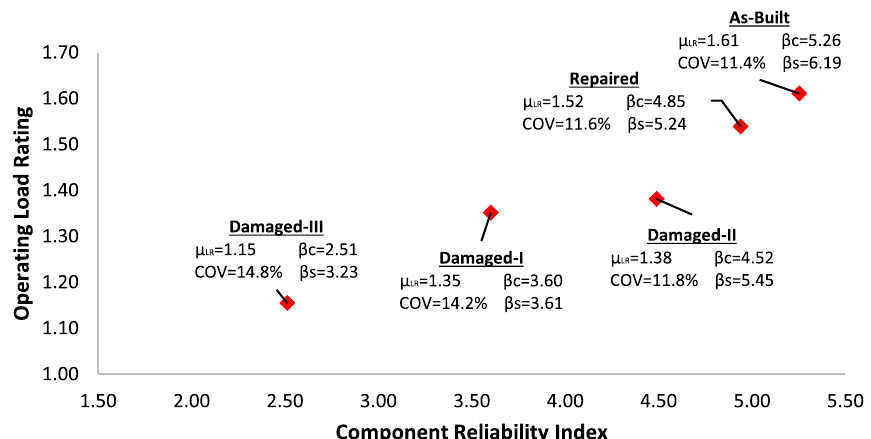
Fig. 14 The mean of HL-93 operating load-rating versus component reliability index of the cases. The mean operating load-rating (µ LR ), component reliability index (β c ), system reliability index (β s ), and Coefficient Of Variation (COV) values are given for each